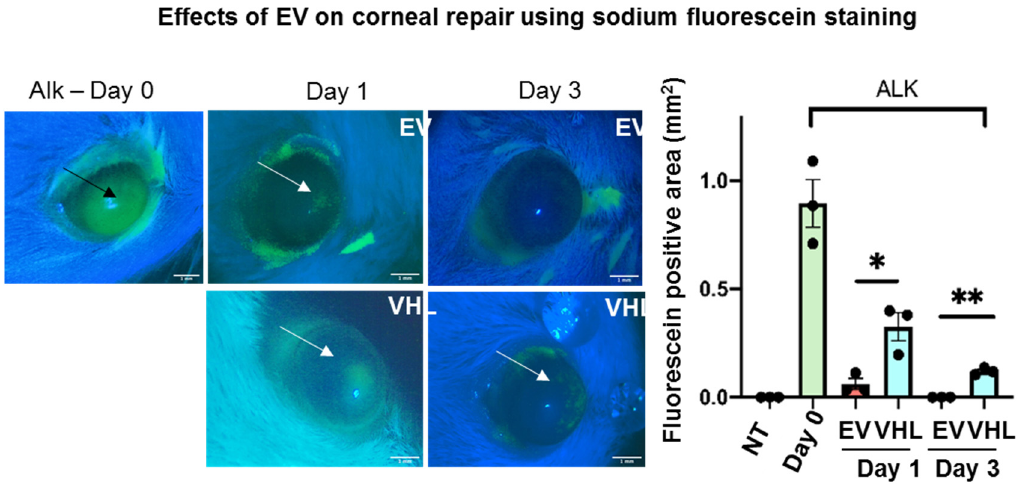
Figure 4. Effects of MSC-EVs on corneal wound repair. Fluorescein staining in vivo immediately following damage induction (ALK day 0; the black arrow shows NaOH-induced damaged area). Damage resolution till day 3 is shown (arrows indicate positivity for fluorescein). The graphical representation of wound repair at days 0, 1 and 3 following alkali burn is shown. Fluorescein-positive areas (mm 2 ) were measured and mean ± SD is shown; n = 3 (representative of 2 independent experiments), * p < 0.05, ** p < 0.01. Scale bar = 1 mm. ● represents biological replicates.